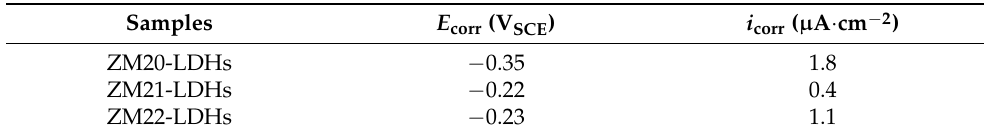
Figure 6. Tafel polarization curves of ZM20-LDHs, ZM21-LDHs, and ZM22-LDHs films in 3.5 wt.% NaCl solution. Table 3. Corrosion potential ( E corr ) and corrosion current density ( i corr ) of the samples according to the Tafel polarization curve.